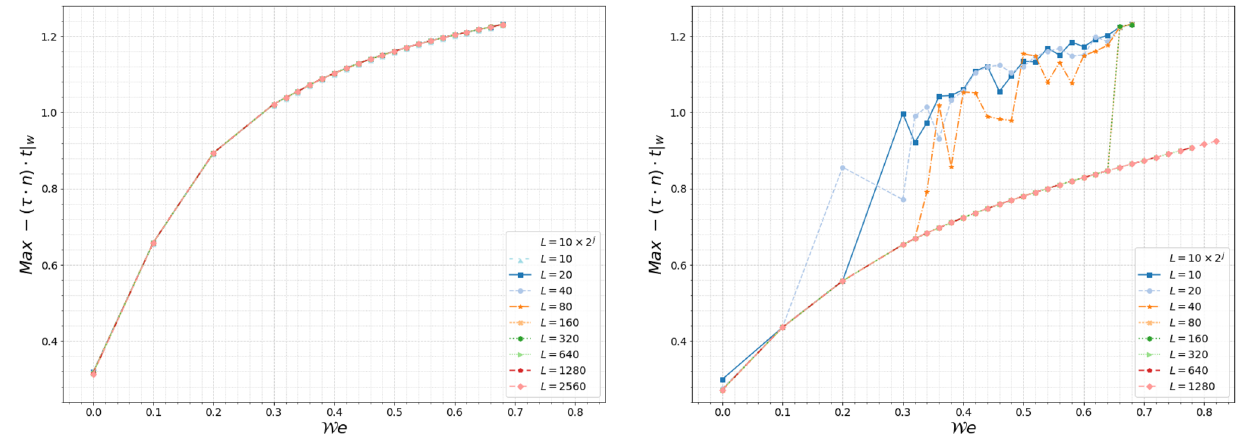
𝝉 ) (left) and 𝛼 ( ) (right) depending on p t t ‖ ‖ ‖ ‖